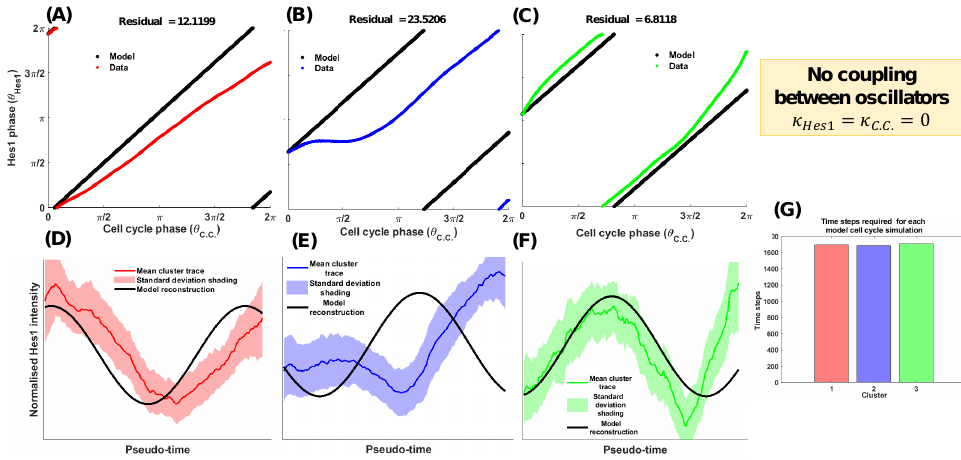
Figure 4. Results of the solutions to model Equation (5) with the constraint κ Hes1 = κ C.C. = 0 ( i ) ( i ) when θ is optimised to the data vector Θ , i = 1,2,3, the frequency parameters are set as Hes1 Hes1 ω Hes1 = 24 − 1 and ω C.C. = 27 − 1 . ( A – C ) Square torus diagram trajectories of solutions θ 2, 3 superimposed over data trajectories from Figure 2B. ( D – F ) Pseudo-time plots of rebuilt Hes1 (cid:16) (cid:17) ( i ) θ dynamics found via cos , i = 1,2,3 superimposed over mean traces from Figure 2A. In ( A – F ), Hes1 the black lines denote the model results, coloured lines denote the data (red: cluster 1, blue: cluster 2 and green: cluster 3) and in ( D – F ) the shaded areas denote the standard deviations of the data. ( G ) Bar chart of cell cycle duration predictions from the simulation for each cluster